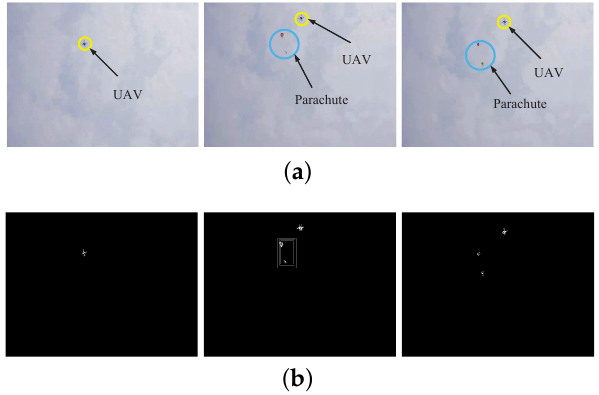
Figure 18. Original frame and foreground. ( a ) Original frame, ( b ) foreground.